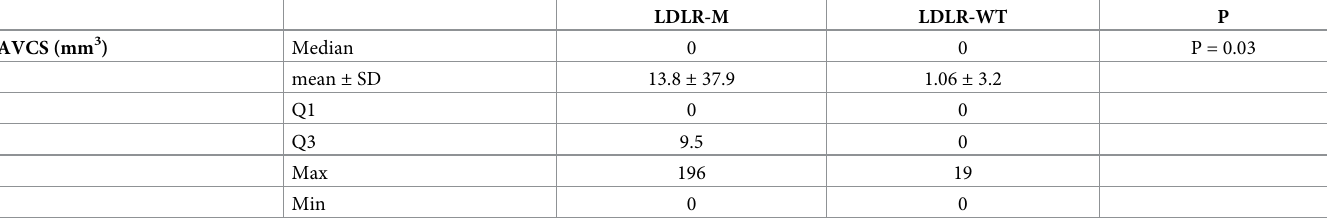
Table 2. Volumetric calcium score of aortic valve in LDLR-M and LDLR-WT